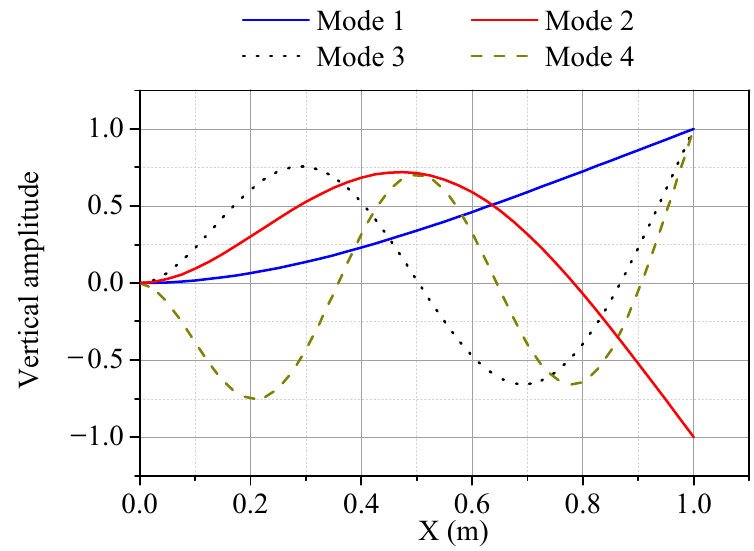
Figure 5. The fi rst four vibration modes of the